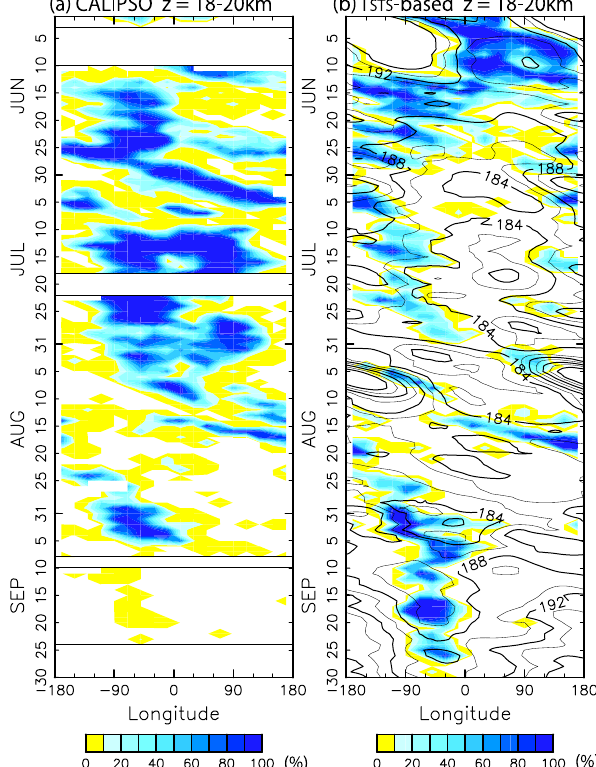
Fig. 4. The same as Fig. 3a and c but for the latitude range of 75 ◦ S– 80 ◦ S.